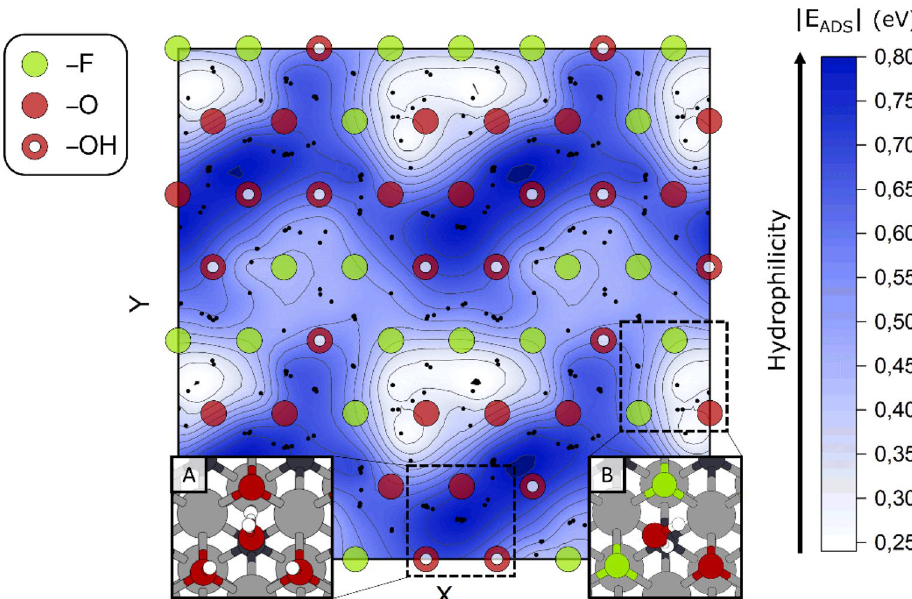
Fig. 5 Hydrophilicity map of a 2 2 Ti 2 CT x with mixed terminated surface. The two axes identify the lateral displacement on the surface, referring × to the termination positions. Terminations are shown in relief on the map. Hydrophilic regions (blue) are those rich in hydroxyl groups, where hydrogen bond networks are easily formed (inset A). White regions correspond to less hydrophilic areas, where H 2 O interacts only moderately with the surface (inset B). Black tiny dots identify the average x and y coordinates of H 2 O, for each of the 96 optimized water molecules